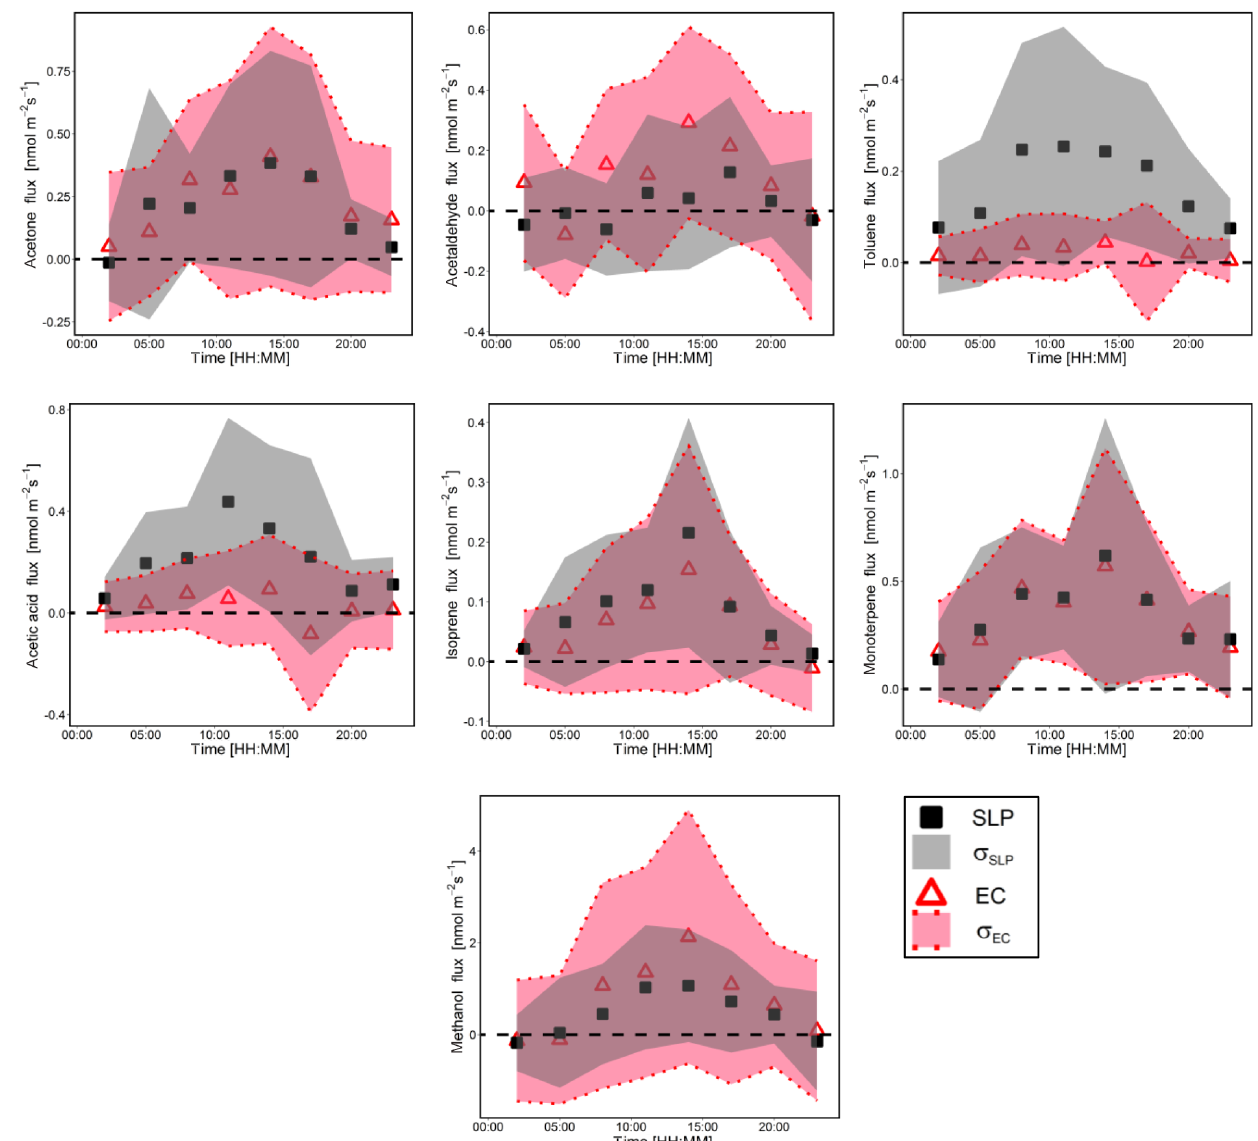
Figure 9. Diurnal mean and standard deviation of the eddy covariance (red triangles) and the surface layer profile (black squares) flux of the major compounds measured by EC and SLP. The data are from April to the end of June